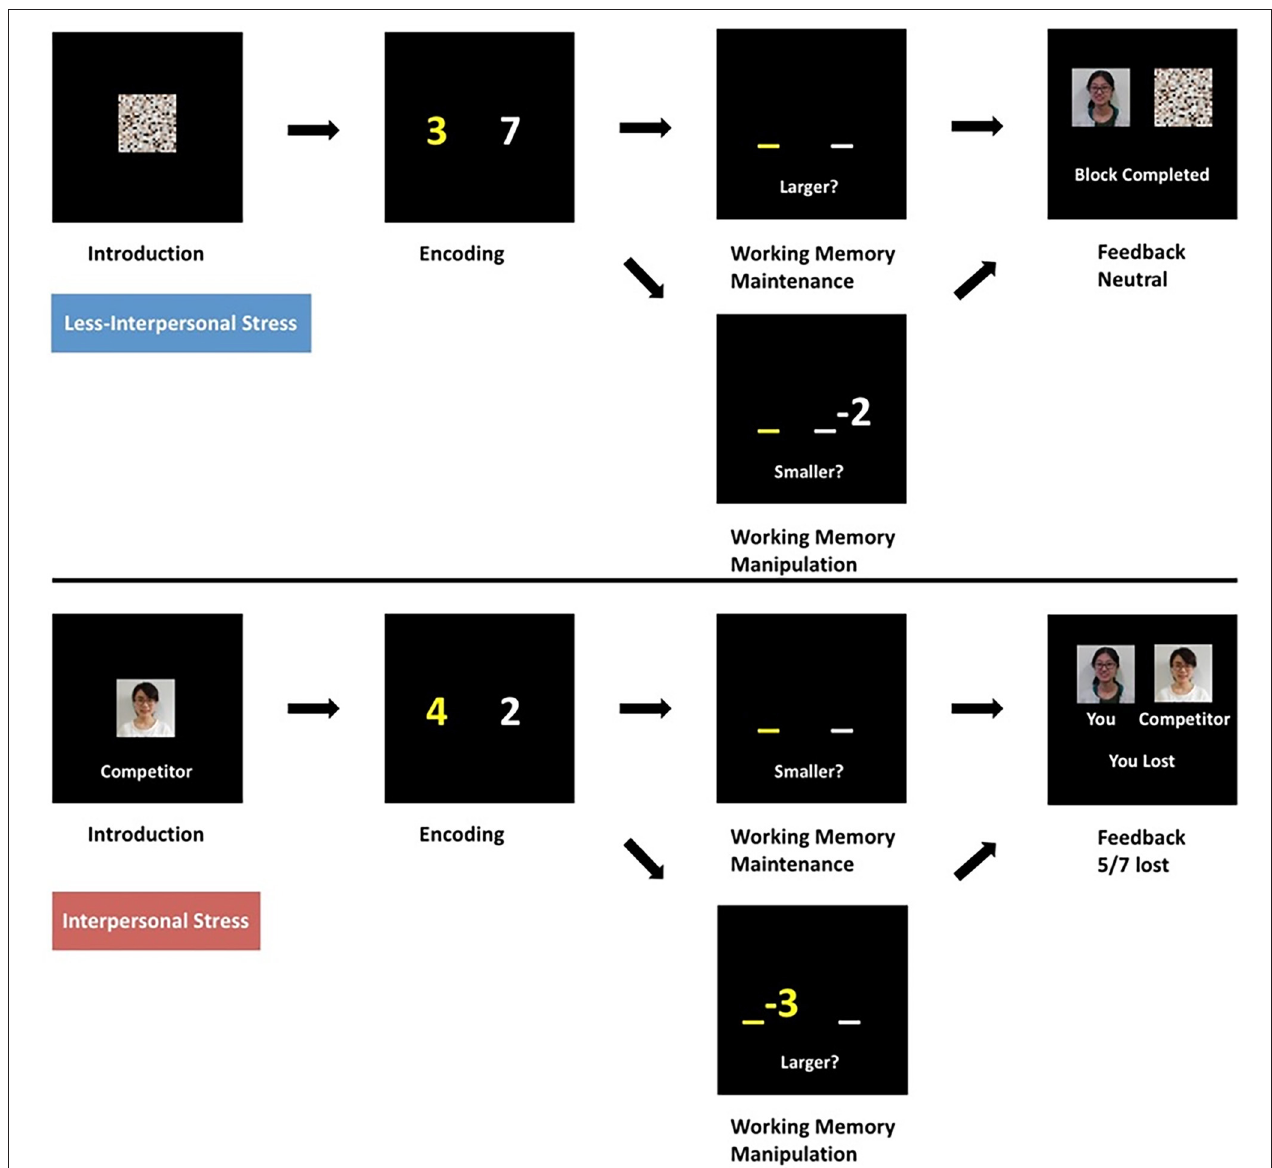
FIGURE 1 | Working memory paradigm incorporating social competition stress. In the stressed component, subjects were led to believe that they were playing against a “competitor” of similar age and gender and were judged as winning or losing based on their speed and accuracy, which subsequently resulted in ∼ 70% loss feedback. In the less stressed blocks, there was no competitor, and subjects received neutral feedback. In all the working memory manipulation and maintenance tasks, an array of two-number digits was encoded and held in working memory over 3 to 4s. In working memory maintenance condition, subjects responded to which of the two maintained digits was larger or smaller as indicated. In working memory manipulation condition, subjects performed subtraction on one of the numbers held in working memory, followed by a response as to which result was larger or smaller as indicated. Subjects performed two runs counterbalanced for trial and stimuli presentation order over ∼ 20min. All instructions were translated to Chinese.